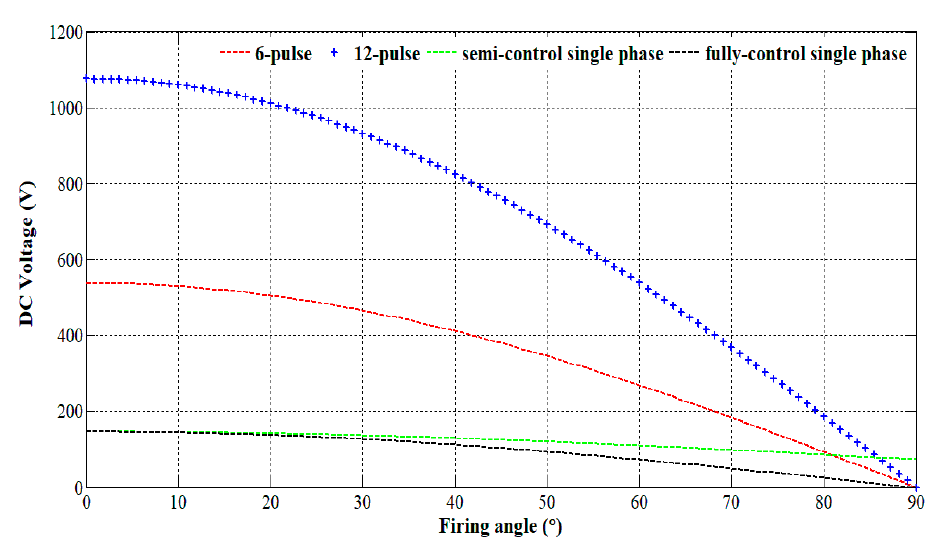
Figure 15. Six-pulse diode bridge rectifier with a two-phase stacked interleaved buck converter.